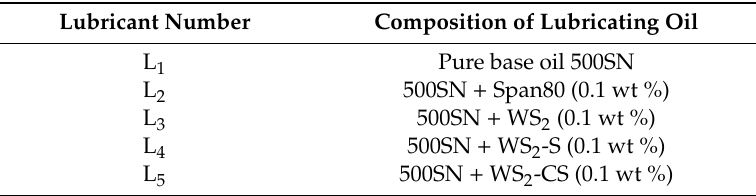
Table 3. Lubricating oils with di ff erent types of additives.